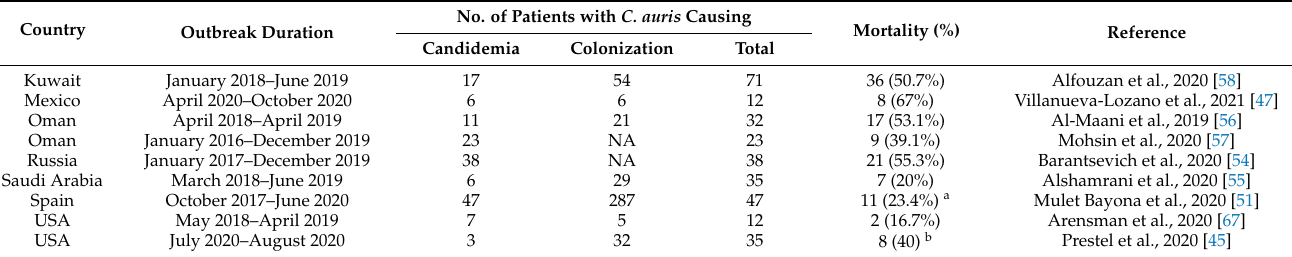
Table 1. Number of patients affected and mortality rates in selected studies reporting outbreaks during January 2019 to January 2021. a Outcome reported for candidemia patients only b Clinical details available for only 20 patients; NA, not